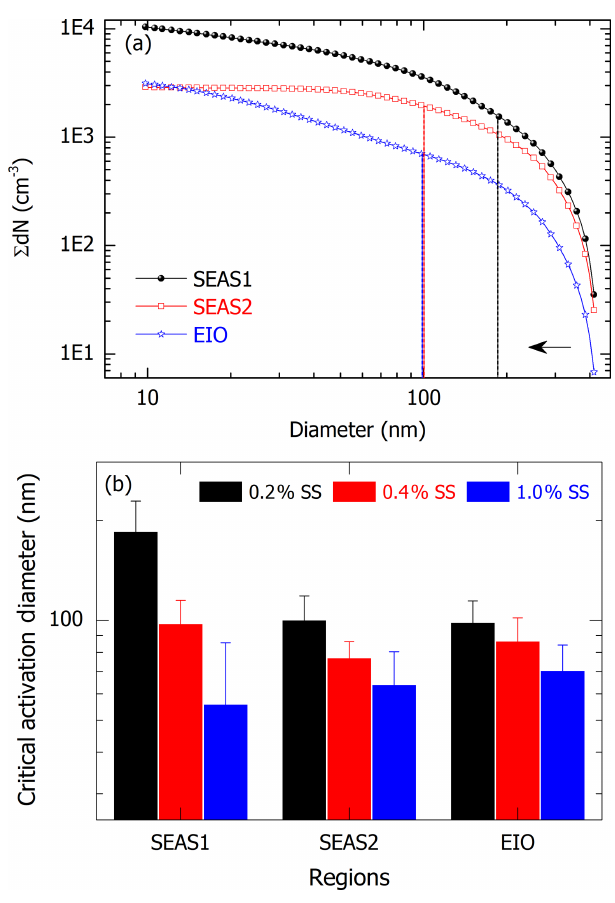
Figure 10. (a) Cumulative aerosol number concentration from higher size range to lower over SEAS1, SEAS2 and EIO. The value at 9nm indicates the total number concentration. The apparent crit- ical activation diameter is shown as dashed vertical lines. (b) Varia- tion in critical diameter for 0.2%, 0.4% and 1.0% supersaturations (SS) over SEAS1, SEAS2 and